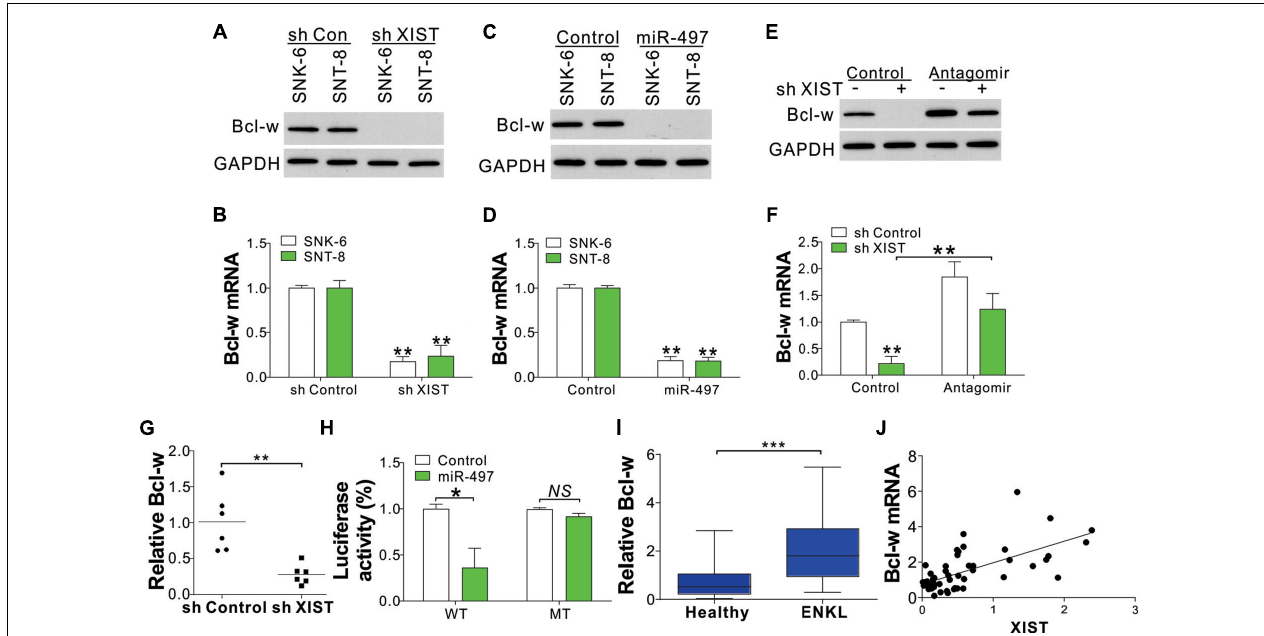
FIGURE 5 | XIST/miR-497 modulates Bcl-w expression in ENKL cells. (A,B) The protein (A) and mRNA (B) levels of Bcl-w in ENKL cells stably treated with a control or XIST shRNA. (C,D) The protein (C) and mRNA (D) levels of Bcl-w in ENKL cells treated with an miR-497 mimic. (E,F) The protein (E) and mRNA (F) levels of Bcl-w in SNK-6 cells stably transfected with a control or XIST shRNA with or without miR-497 antagomir transfection. (G) The mRNA expression of Bcl-w in tumors of mice xenografted with SNK-6 stably transfected with a control or XIST shRNA ( n = 6). (H) The luciferase reporter activity of a wild-type (WT) or mutant Bcl-w reporter in SNK-6 cells stably transfected with a control or miR-497. The effect of miR497 on luciferase activity was normalized to control RNA transfection in each group. (I) The mRNA level of Bcl-w in ENKL patients ( n = 54) and healthy donors ( n = 24). (J) The correlation of Bcl-w mRNA and XIST expression in 54 ENKL patients. Each experiment was repeated for 3 times. NS, p > 0.05; * p < 0.05; ** p < 0.01; *** p <